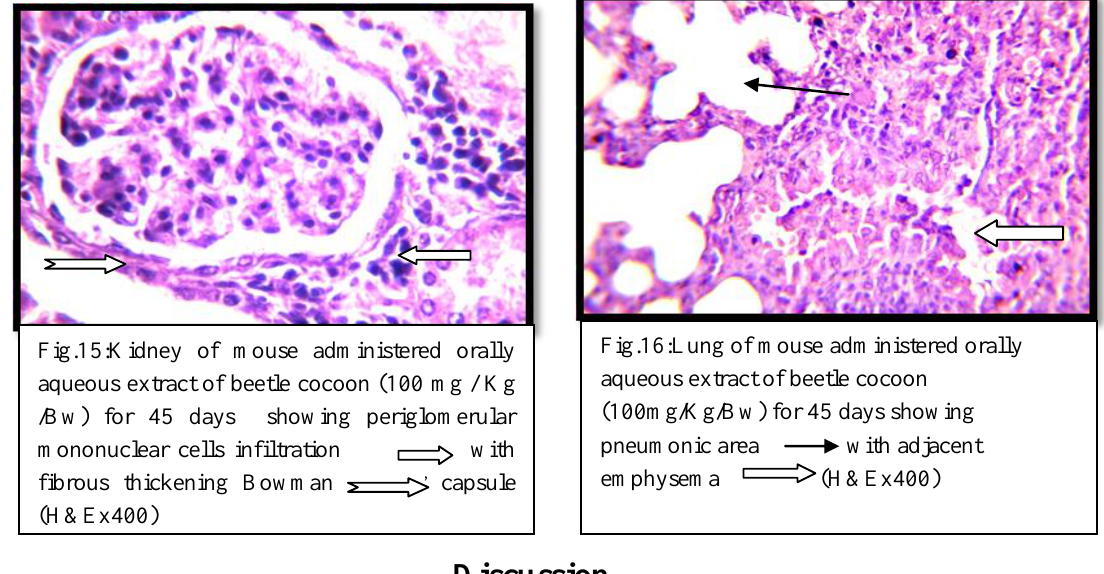
Fig.15:Kidney of mouse administered orally aqueous extract of beetle cocoon (100 mg / Kg /Bw) for 45 days showing periglomerular mononuclear cells infiltration with fibrous thickening Bowman , capsule